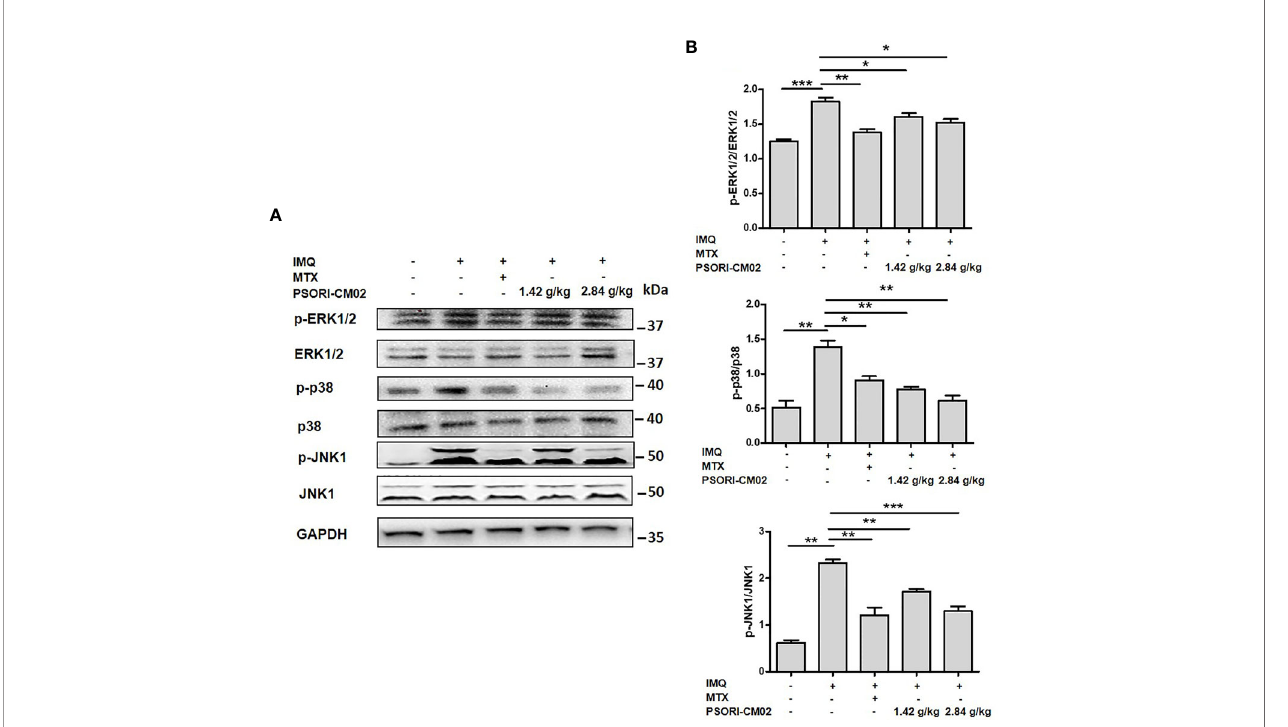
FIGURE 6 | Effects of PSORI-CM02 on the MAPK signalling pathway in mice with (IMQ)-induced psoriasis. (A) Representative western blot of MAPK pathway protein expression in the skin of mice with IMQ-induced psoriasis. (B) Quanti fi cation of phospho-ERK1/2, phospho-p38, and phospho-JNK1 relative to ERK1/2, p38, and JNK1 in the skin of mice (* p < 0.05, ** p < 0.01, *** p < 0.001 vs. the IMQ-induced psoriasis group; n =